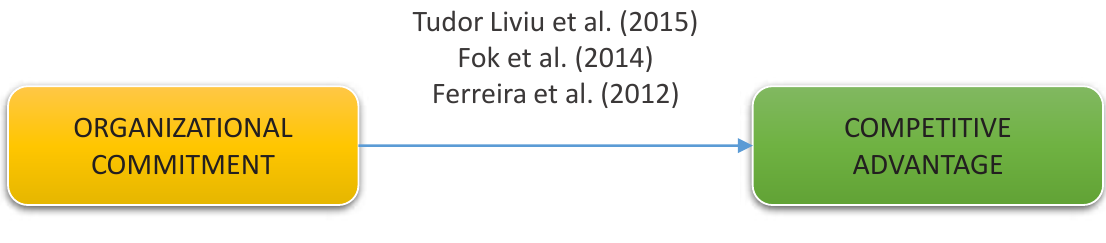
Figure 6. Organizational change management relationship toward competitive advantage